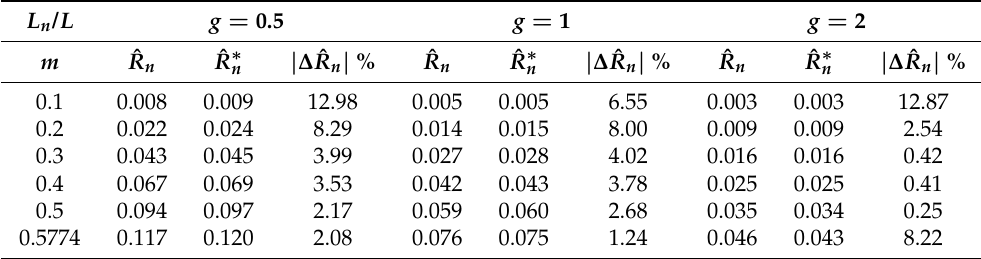
Table 7. Neutral-current-ripple RMS experimental error assessment for L n = L /2, L n = L , and L n = 2 L (i.e., g = 0.5, g = 1, and g =